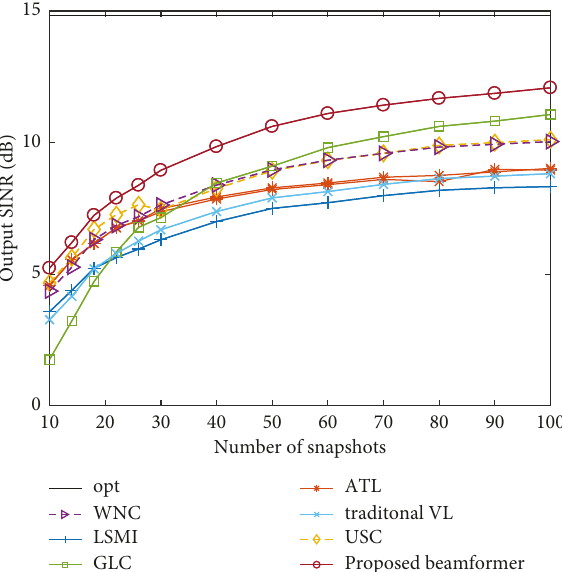
Figure 3: Output SINR versus input SNR in sufficient snapshot.